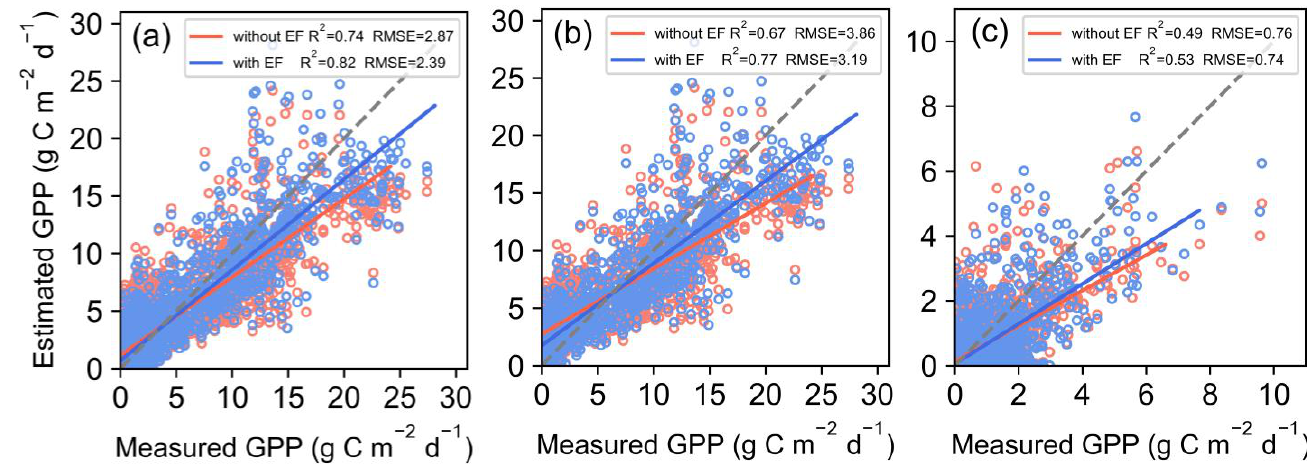
Figure 2. Comparisons of GPP between estimation by the models and ground measurements by eddy covariance system at cropland flux tower sites (using validation dataset): ( a ) whole year; ( b ) summer half year (Spring Equinox (21 March) to Autumn Equinox (23 September)); and ( c ) winter half year. EF data were from flux tower measurements. The blue and red points represent GPP estimated by the EF-LUE model and by the model without EF, respectively. The solid lines are the regression lines, and the gray dashed lines are the 1:1 line.